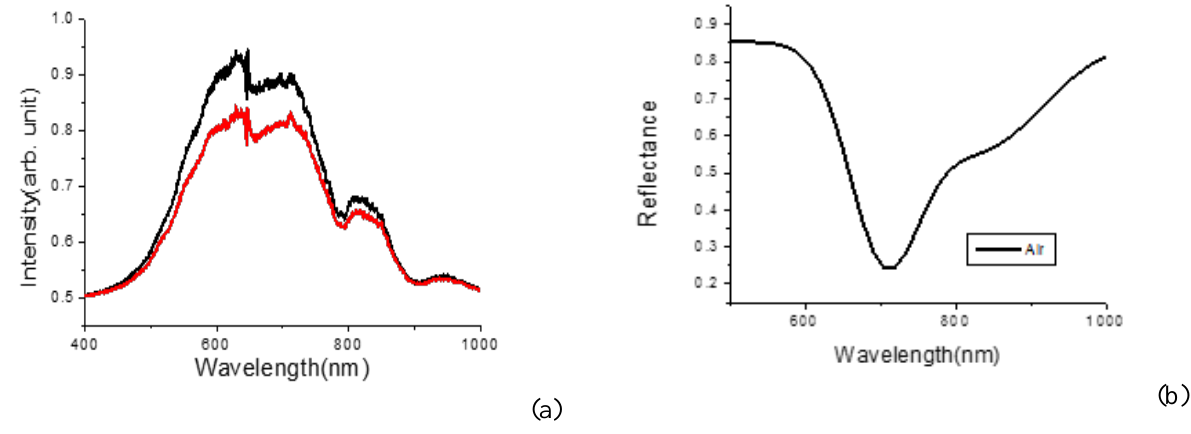
Figure 6. (a) The spectrum of the polychromatic light through measured origin spectrum for a bare region of optical fiber, sensitive region in the air with n =1; (b) Reflected